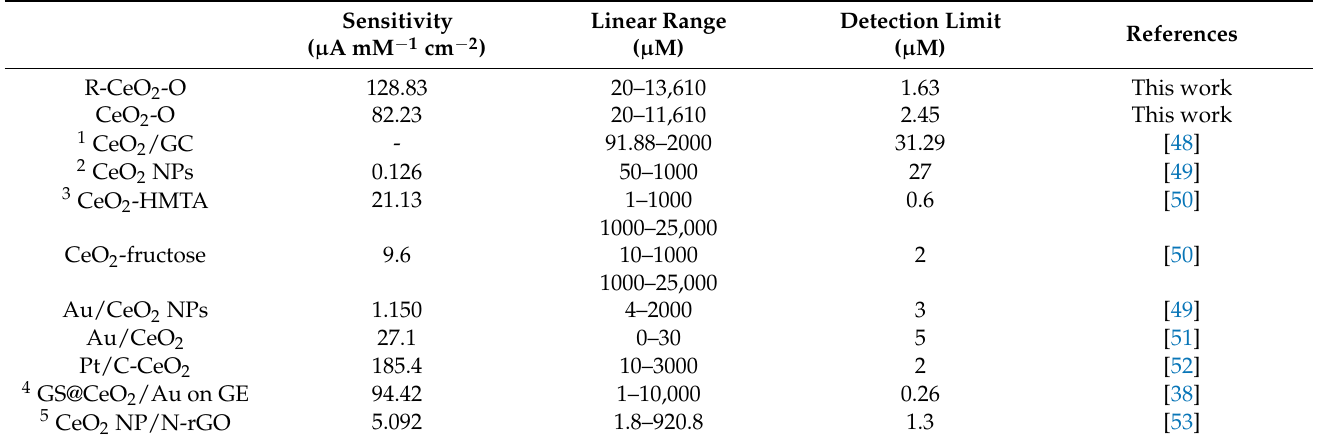
Table 1. Comparison of sensitivity, linear range, and detection limit of various H 2 O 2 sensors con- structed on the basis of CeO 2 -dominated electrode